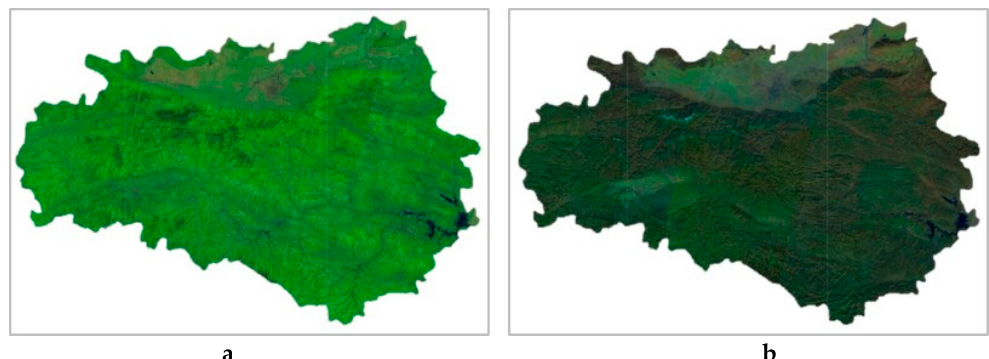
Figure 3. Composition result from April to September ( a ) and October to March ( b ).